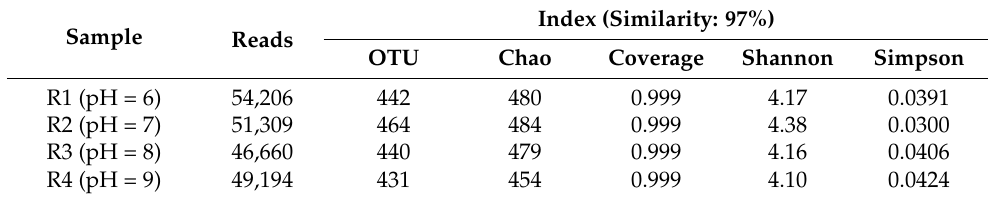
Table 2. Alpha diversity of biofilm under different influent pH.